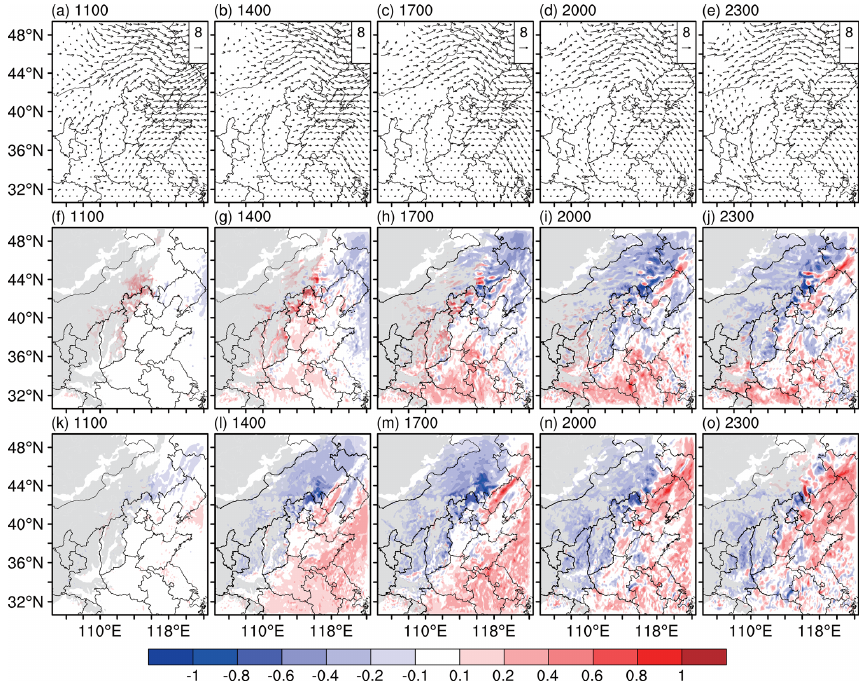
Figure 19. The wind at 850hPa (vector) at 11:00, 14:00, 17:00, 20:00 and 23:00LT in NoAero averaged during 6 to 10 December 2015. The difference of (f–j) U and (k–o) V wind speed between Aero and NoAero (Aero minus NoAero). The gray areas denote the areas of terrain height above